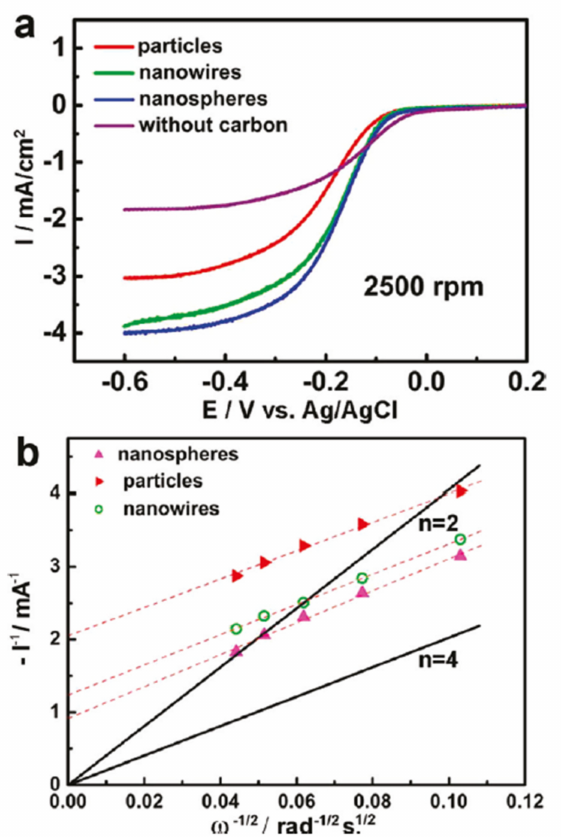
Figure 5. ( a ) Comparison of the LSV of α -MnO 2 bulk particles, nanowires, nanosphere (nanoflowers) and nanowires without carbon in 0.1M KOH electrolyte at 2500 rpm, and ( b ) the K-L plot for α -MnO 2 nanospheres (nanoflowers), bulk particles and nanowires at − 0.3 V. Reprinted with permission from [19]. Copyright 2010 American Chemical Society.